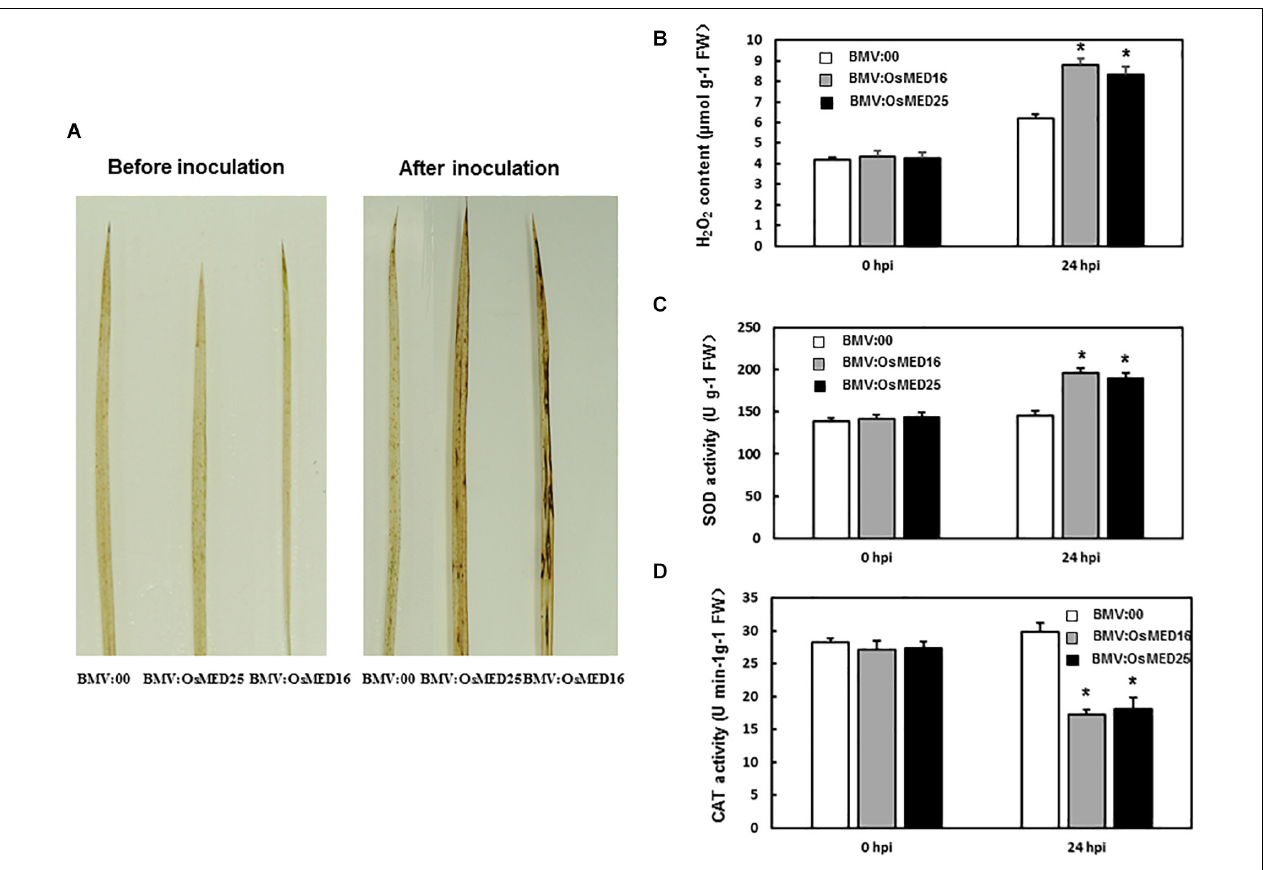
FIGURE 7 | The H 2 O 2 condition in BMV: OsMED16-, BMV: OsMED25-, and BMV:00-infiltrated plants before and after Magnaporthe grisea inoculation. (A) The DAB staining of leaves from BMV: OsMED16-, BMV: OsMED25-, and BMV:00-infiltrated plants before and after M. grisea inoculation. (B) The H 2 O 2 content in BMV: OsMED16-, BMV: OsMED25-, and BMV:00-infiltrated plants before and after M. grisea inoculation. (C) The SOD activity in BMV: OsMED16-, BMV: OsMED25-, and BMV:00-infiltrated plants before and after M. grisea inoculation. (D) The CAT activity in BMV: OsMED16-, BMV: OsMED25-, and BMV:00-infiltrated plants before and after M. grisea inoculation. *Above the columns indicate significant differences at p < 0.05 between the silencing plants and the control.